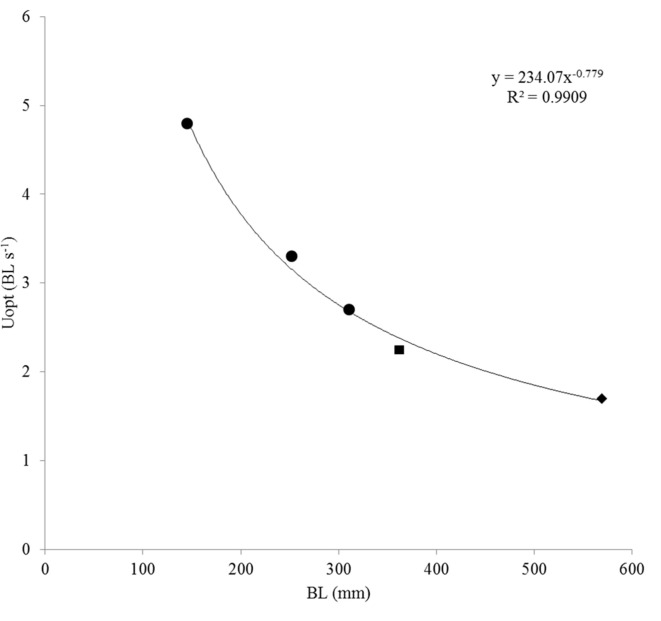
Optimal swimming speed Uopt (in body length per second BL s−1) in relation to size in BL. Shown are the three Uopt-values obtained in this study (circles) of group 1 (4.85 BL s−1), group 2 (3.25 BL s−1) and group 3 (2.73 BL s−1); the Uopt (2.25 BL s−1) of yellowtail kingfish of size 362 ± 15 mm, 699 ± 39 g as reported by Brown et al. (2011; square) and the Uopt (1.7 BL s−1) of yellowtail kingfish of size 569 ± 26 mm, 2.35 ± 0.31 kg as reported by Clark and Seymour (2006; diamond). Best of fit is a power function: y = 234.07x−0.779 (R2 = 0.9909). Note that BL for fish of the study by Brown et al. (2011; square) is in fork length, adding 30–40 mm to estimate the TL-values leads to a perfect fit of this data point on the trend line.